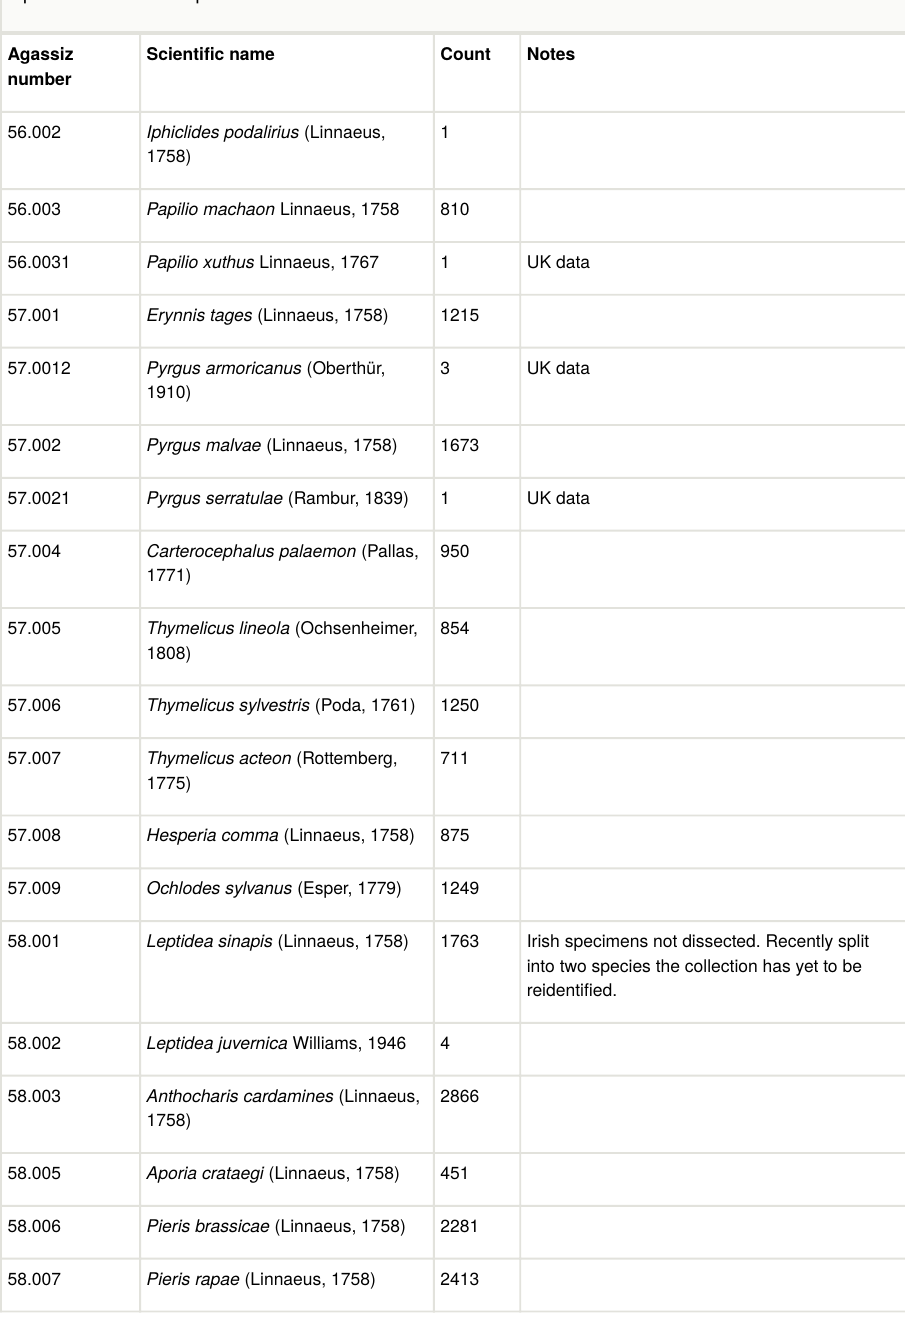
Table 1. Species in the NHMUK British and Irish butter fl y collections together with counts of the numbers of specimens of